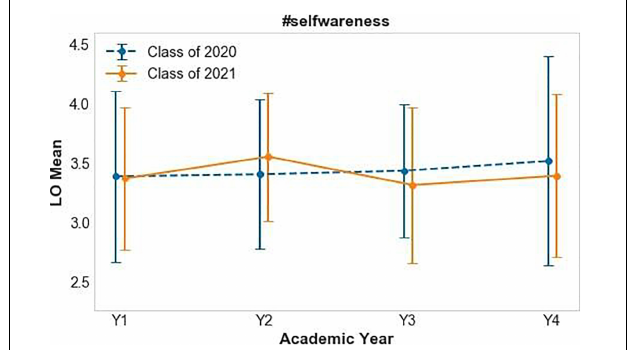
FIGURE 1 | Mean and standard deviation of scores on #selfawareness earned by two cohorts, the class of 2020 and the class of 2021 (who began in the fall of 2016 and 2017, respectively). Numbers of students in each year and score count are presented in Supplementary Material 8